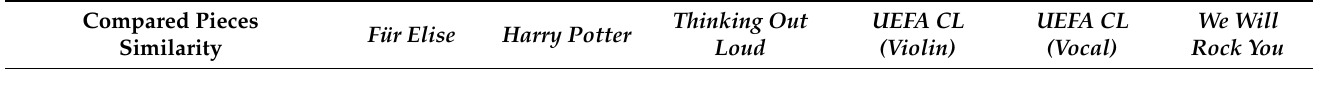
Table 6. Comparison of pieces between